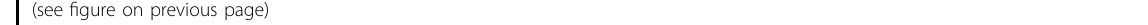
Fig. 3 Altered differentiation of laminopathic BAT precursors. a Differentiation rate of control and FPLD2 BAT precursors is shown in the upper graph. The number of cells with lipid droplets observed by phase-contrast microscopy is reported. Lipid droplet diameter frequency in control and FPLD2 BAT adipocytes at day 9 of differentiation is shown in the lower graph. Data are the percentage of total counted vesicles (300 per sample in three different samples). b Representative images of cultured control and FPLD2 living cells at day 9 during BAT differentiation (phase-contrast living cells) and electron microscopy images of the same cell culture (electron microscopy). L, lipid droplet; m, mitochondrion. Bars, 10 μ m for phase- contrast pictures, 1 μ m for electron microscopy. c Quanti fi cation of PPARG , UCP1 , DIO2 , and PRDM16 expression by qRT-PCR in control and FPLD2 cells under basal conditions (ND) or after 20 days of differentiation toward the brown lineage (BAT). Statistically signi fi cant differences between control and the corresponding FPLD2 cells are indicated (*). d Western blotting and densitometric analysis of PPAR γ in control and FPLD2 adipocyte precursors under basal conditions (ND) or after 20 days of differentiation (BAT). The actin band is shown as a loading control. Western blotting and densitometric analysis of PPAR γ isoforms in isolated control and FPLD2 adipocyte (BAT) nuclei is shown on the right. C-EBP α bands were stained as loading controls, indicating comparable amounts of adipocytes. Molecular weight markers are reported in kDa. e Quantitative RT-PCR analysis of WAT markers leptin, GLUT4 , and ADIPOq in control or FPLD2 brown adipocyte precursors. Three biological replicates were used in each experiment as well as in qRT-PCR analyses. Data are means of three independent experiments± SD. Statistically signi fi cant differences ( p < 0.05) between control and corresponding FPLD2 samples are indicated